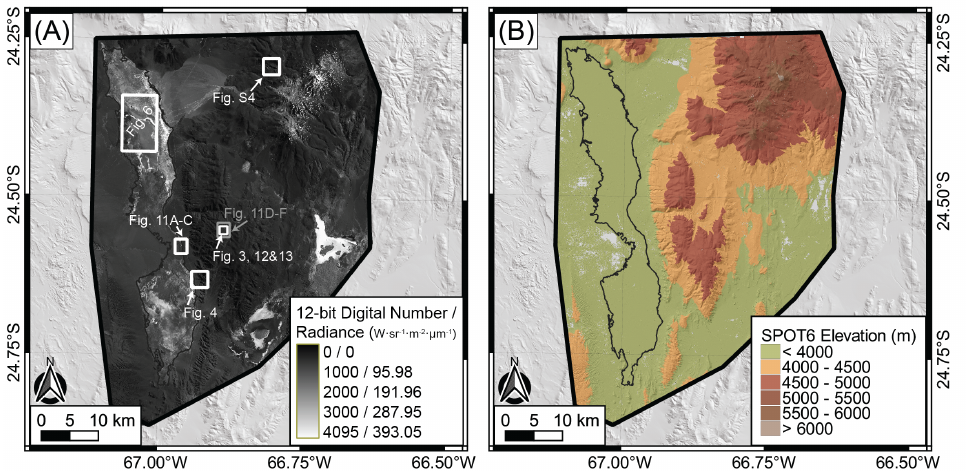
Figure 2. Same area shown in Figure 1B overlain with SPOT6 data: ( A ) SPOT6 panchromatic (PAN) B-scene shown in grayscale as 12-bit digital numbers (values of 0-4095) and converted to top-of- atmosphere radiance (units of W/m 2 /sr/ µ m) by dividing the digital number by the gain constant value of 10.4186 and adding the bias constant value of 0, both found in the SPOT6 metadata. Note the spectral range of the SPOT6 PAN channel is 0.450–0.745 µ m. Boxes and labels indicate the areas of subsequent figures in the main text and Supplemental Material; ( B ) topography from SPOT6 DEM BM-ck25 (cf. Table 1) following ASP processing. Holes in the DEM are shown by gray colors, particularly prominent on alluvial fans where image texture is